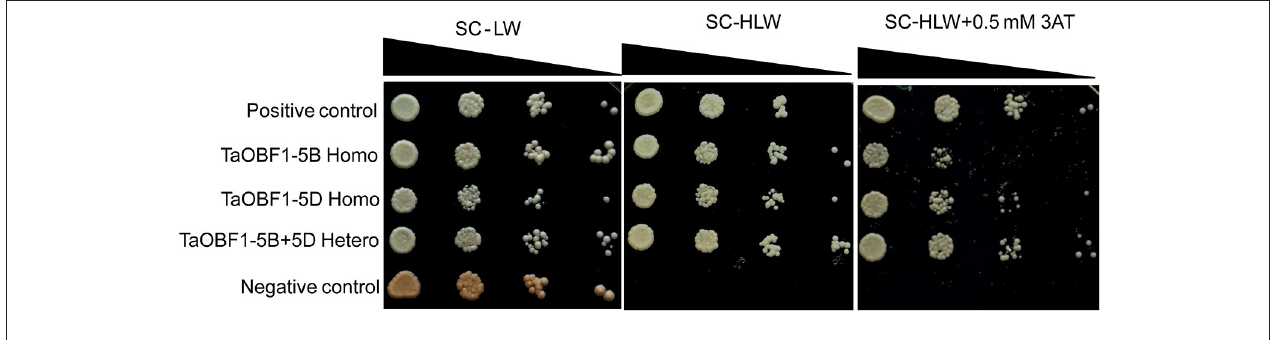
FIGURE 4 | Homo-dimerization and hetero-dimerization of TaOBF1-5B and TaOBF1-5D. Yeast-two-hybrid (Y2H) assay was performed to check the homodimerization of TaOBF1-5B and TaOBF1-5D by co-transforming pGBKT7-5B and pGADT7-5B (labeled as TaOBF1-5B Homo) and pGBKT7-5D and pGADT7-5D (labeled as TaOBF1-5D Homo), respectively. The Y2H assay was performed to check the heterodimerization of TaOBF1-5B and TaOBF1-5D by co-transforming pGBKT7-5B and pGADT7-5D (labeled as TaOBF1-5B-5D Hetero). The growth of co-transformed yeast cells was analyzed by drop assay on SD/-Leu/-Trp (-LW) medium, SD/-Leu/-Trp/-His (-HLW) medium, and SD/-Leu/-Trp/-His (-HLW) + 0.5mM 3-aminotriazole medium (3AT). Pair of plasmids pGBKT7-53 and pGADT7-T were used as positive control, and pGBKT7-Lam and pGADT7-T were used as the negative